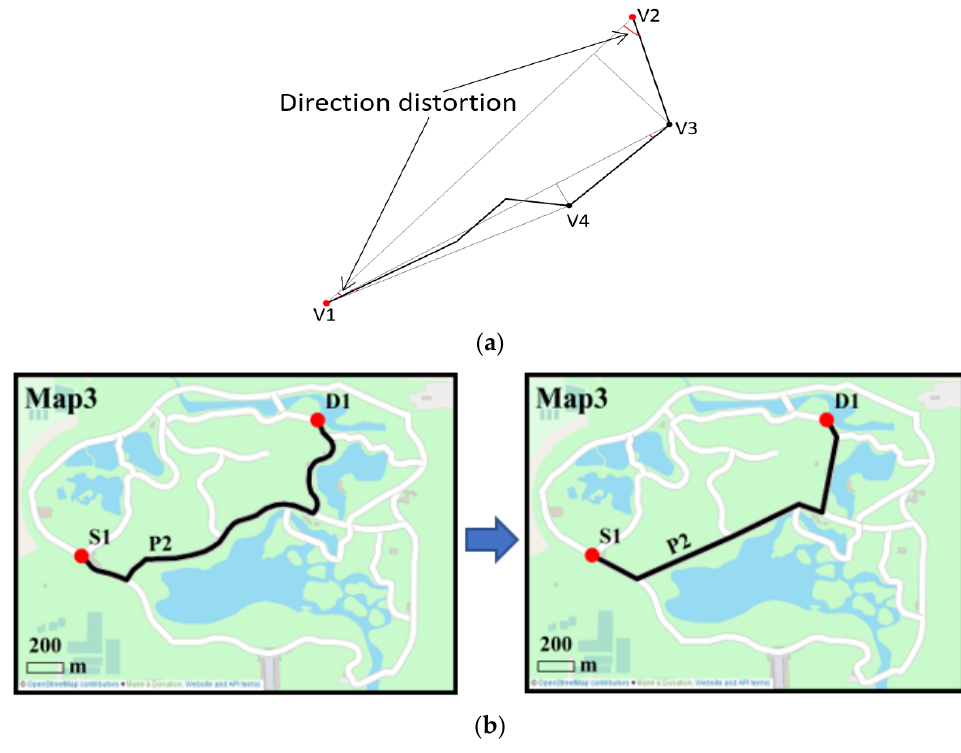
Figure 1. Route shape simplification. ( a ) Line shape simplification using direction distortion. ( b ) Example of a route’s shape